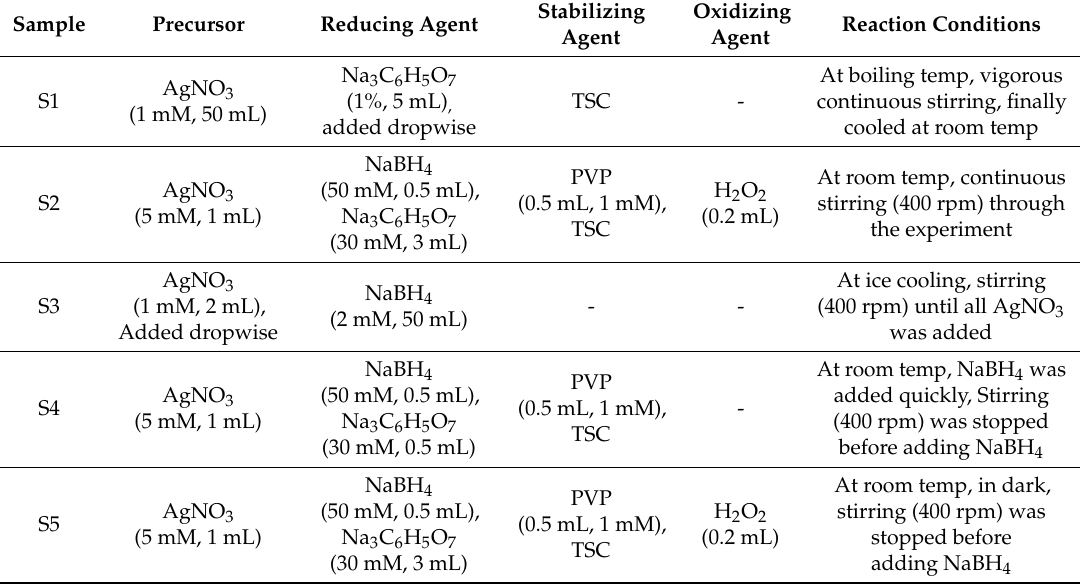
Table 1. Summary of experimental work for the preparation of silver nanoparticles (AgNPs). Silver